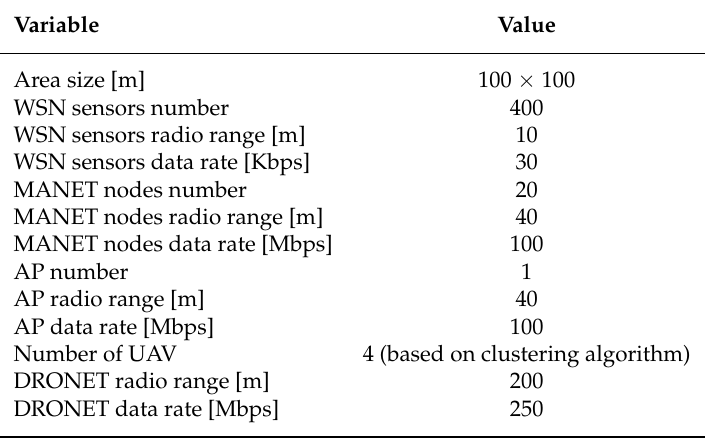
Table 2. Scenario 2 simulation variables